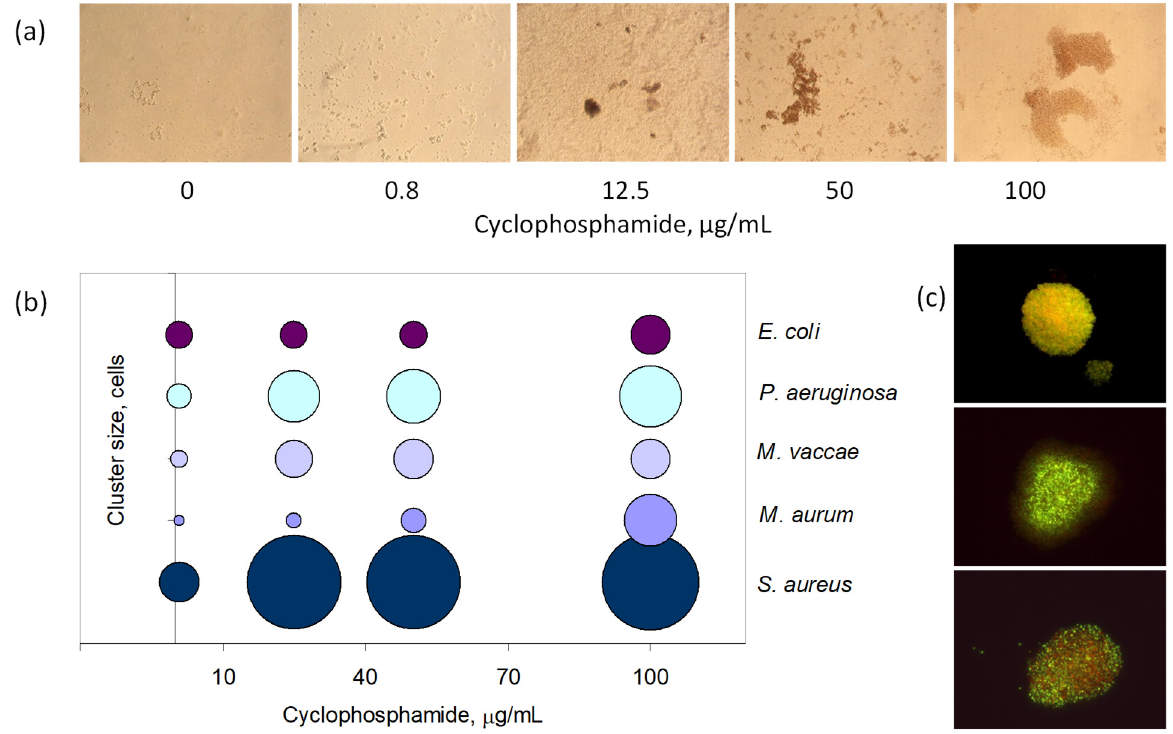
Figure 4. Cell clustering observed during exposure to antineoplastic agents. ( a ) Size of the S. aureus clusters observed during biofilm formation in 6-well plates in cultures with 0.8, 25, 50, and 100 µ g/mL of cyclophosphamide, observed by brightfield microscopy (amplification: 150 × ). ( b ) Average cluster size observed in cultures of S. aureus, M. aurum, M. vaccae, P. aeruginosa, and E. coli exposed to 0.8, 25, 50, and 100 µ g/mL of cyclophosphamide for 24 h. The diameter of the bubbles reflects the number of cells per cluster. ( c ) Clusters of M. aurum cells observed by fluorescence microscopy (amplification: 1500 × ). Healthy cells maintaining a membrane potential are stained red whilst those without a proton motive force across the membrane are stained